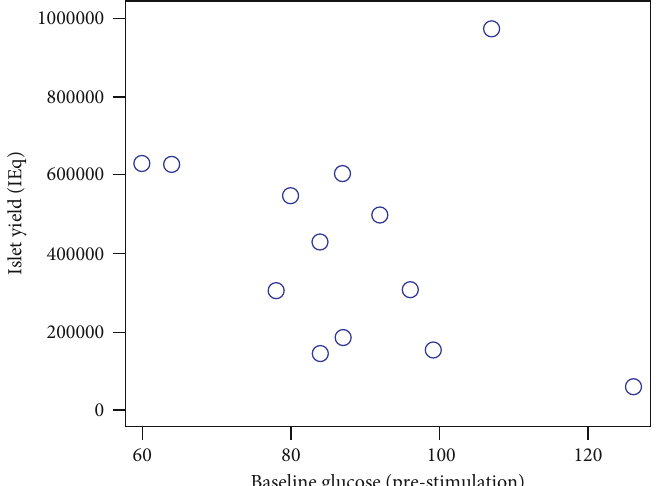
Figure 2: Preoperative baseline glucose prestimulation with glucose plotted against actual islet yield (IEq) intraoperatively. The analysis revealed no statistically signi fi cant correlation of absolute islet yield (IEq) with preoperative baseline